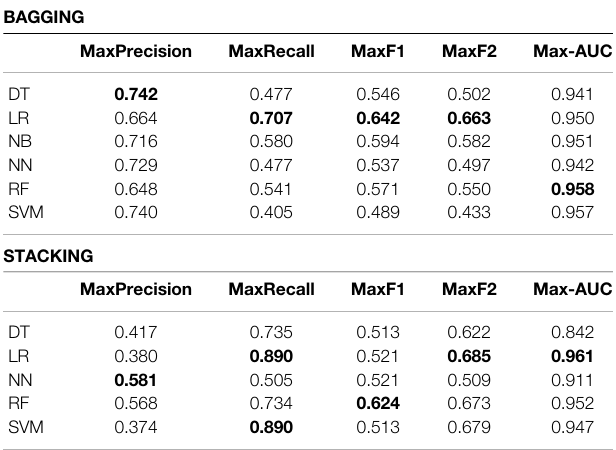
TABLE 3 | Dietary biomarkers ensemble classi fi ers ’ results. Highest precision, recall, F2-score and AUC reached for each algorithm: Decision Tree (DT), Logistic Regression(LR),Naïve Bayes(NB), Neural Network (NN), Random Forest (RF) and Support Vector Machine (SVM). The NB algorithm did not work with the Stacking approach.